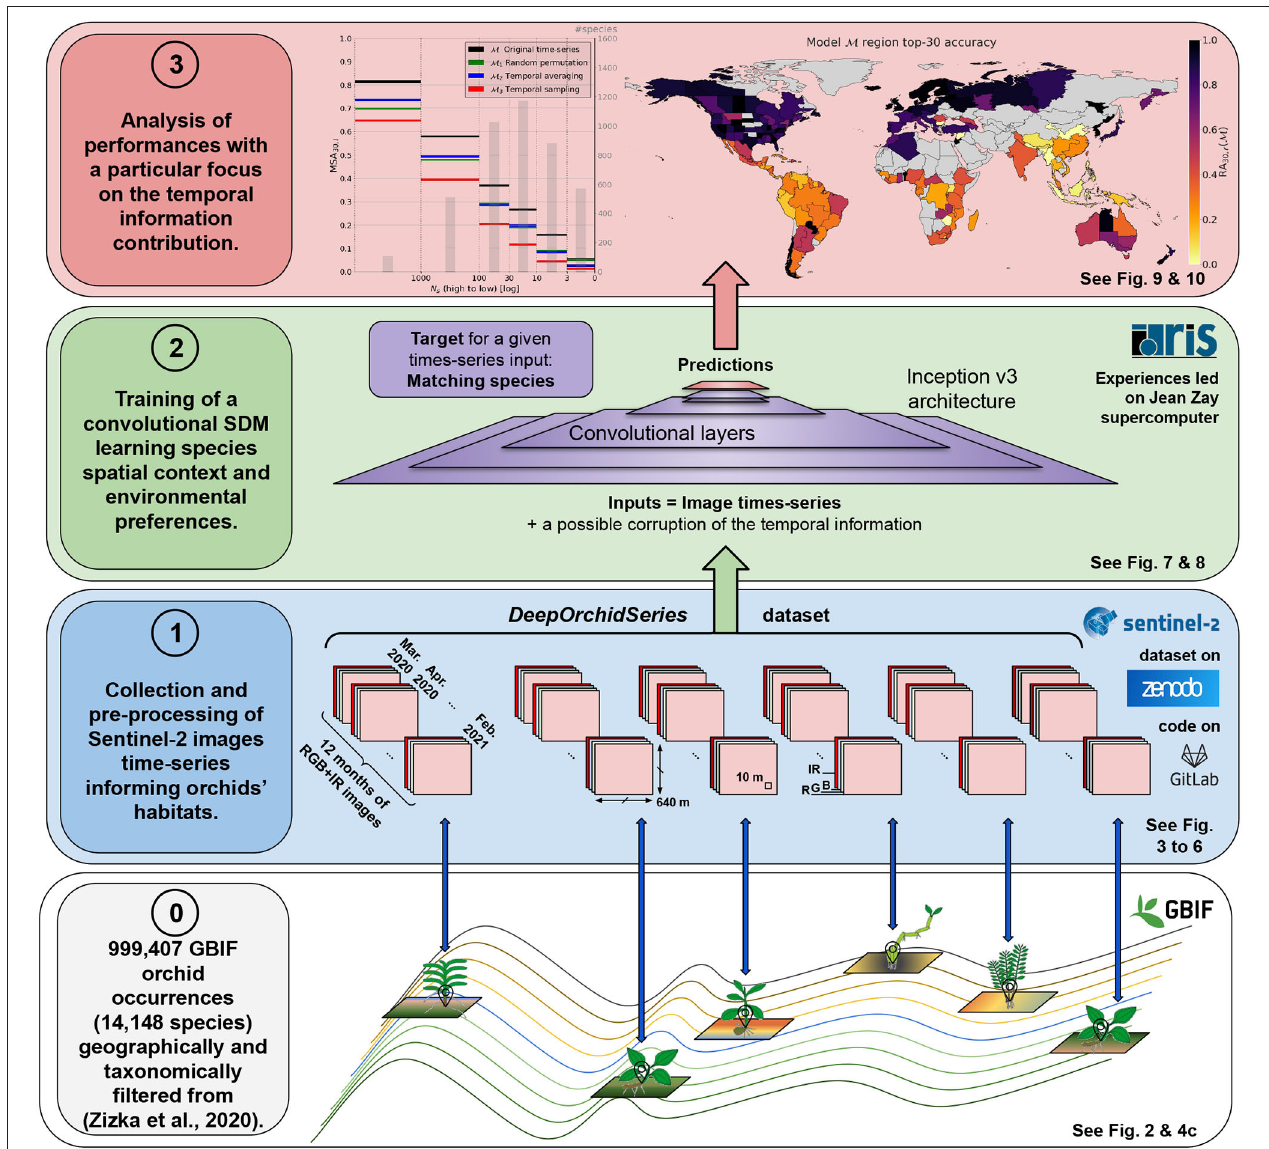
FIGURE 1 | Visual abstract of the proposed method. Layer 0: The dataset introduced in this paper ( DeepOrchidSeries ) is based on a filtered set of GBIF occurrences (Global Biodiversity Information Facility) coming from the study of Zizka et al. (2021). Layer 1: Sentinel-2 image time series were collected around each occurrence geolocation, keeping least cloudy data tiles every month between March 2020 and February 2021. Images are made of 640 x 640 m RGB+IR channels with 10 m spatial resolution. The dataset is available on Zenodo and the method to create it on the Gitlab.inria platform. Layer 2: We then trained deep species distribution models (deep-SDMs) based on a convolutional neural network (CNN) (Inception v3) to capture the spatio-temporal context and environmental preferences of species. Next, we conducted experiments where the input temporal dimension was modified (randomized, averaged or sampled) so as to measure its contribution to model performance. Layer 3: the results are finally broken down into three main dimensions of analysis: species frequency in the dataset, bioregion, and species diversity in these bioregions. The analysis reveals that occurrence-poor species and diversity-rich regions are the ones that benefit the most from the improvement provided by the temporal